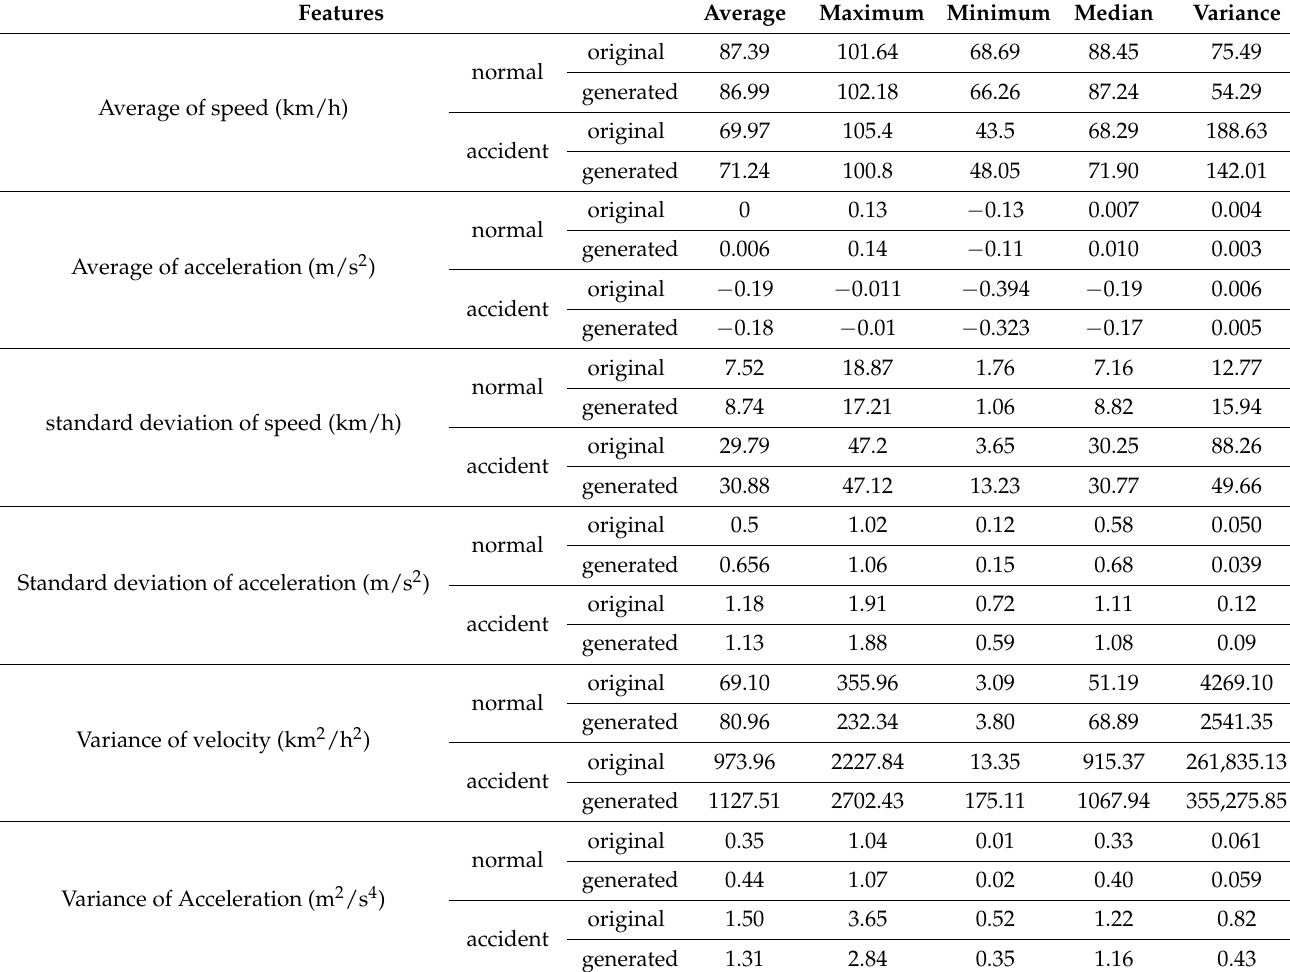
Table 5. Description of original and generated samples under various statistical